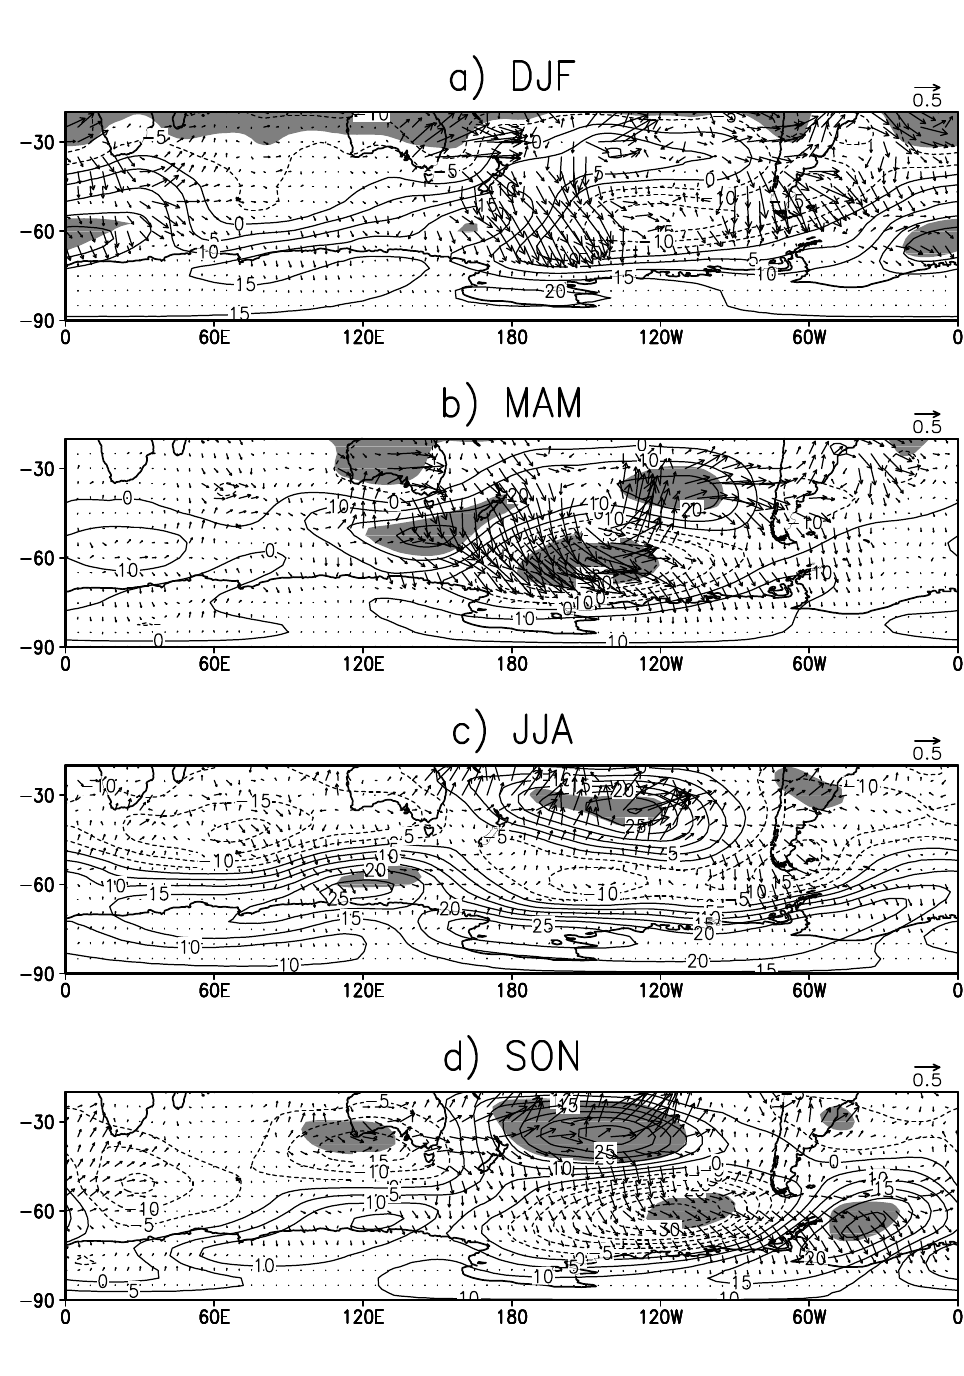
Fig. A6. Same as Fig. A3, but for the La Ni˜na composites and for 500hPa